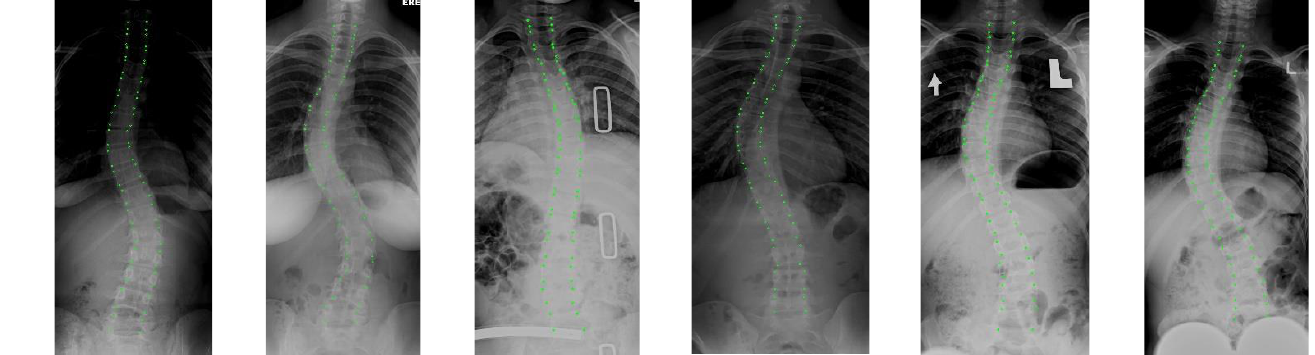
Figure 13. The examples of original image samples.